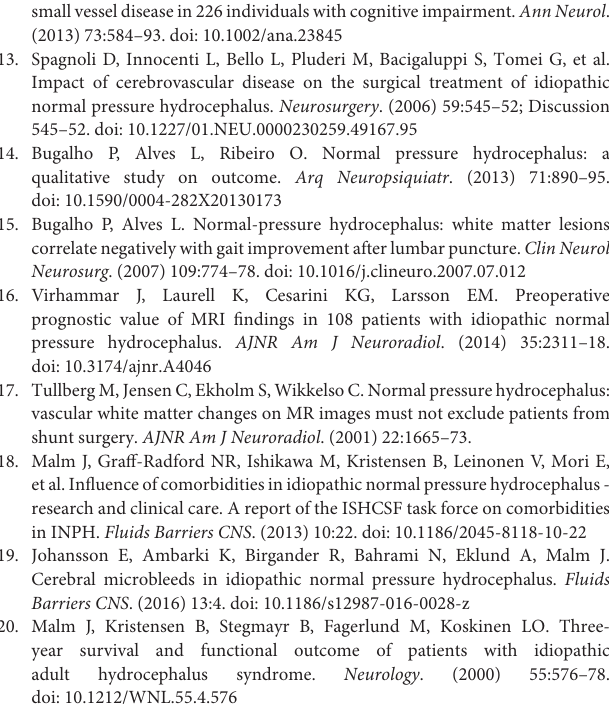
Supplementary Figure 1 | The brain T1-weighted and T2-weighted MR imaging. Both T1-weighted (A–C) and T2-weighted MRI (D–F) demonstrated the similar image feature in all of three cases. (A,D) denoted as INPH (case 1); (B,E) denoted as LA (case 2); (C,F) denoted as CAA (case